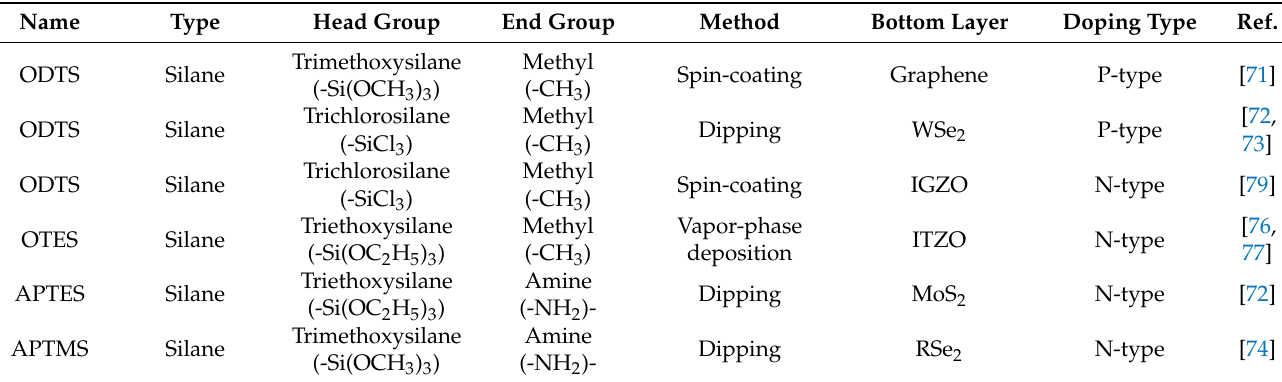
Table 2. Self-assembled monolayers (SAMs) used as a